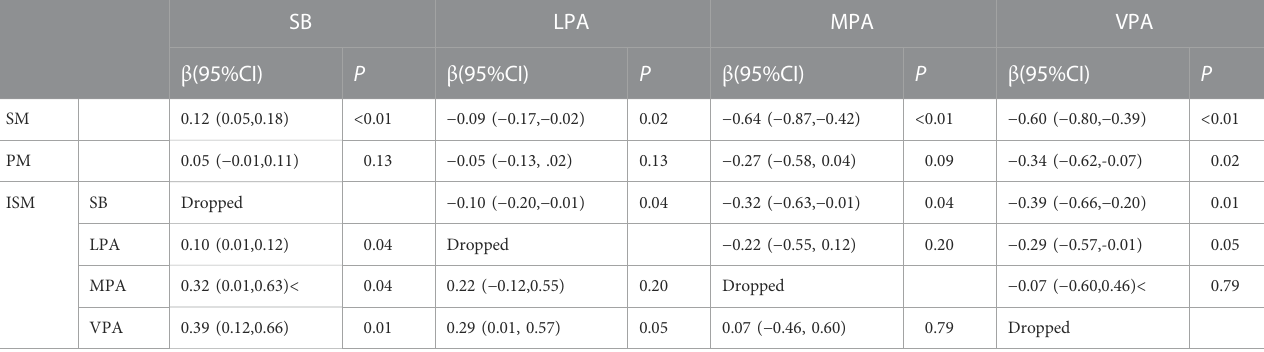
TABLE 5 Effects of three different models on Δ CMR-z after substitution for SB with different intensity physical